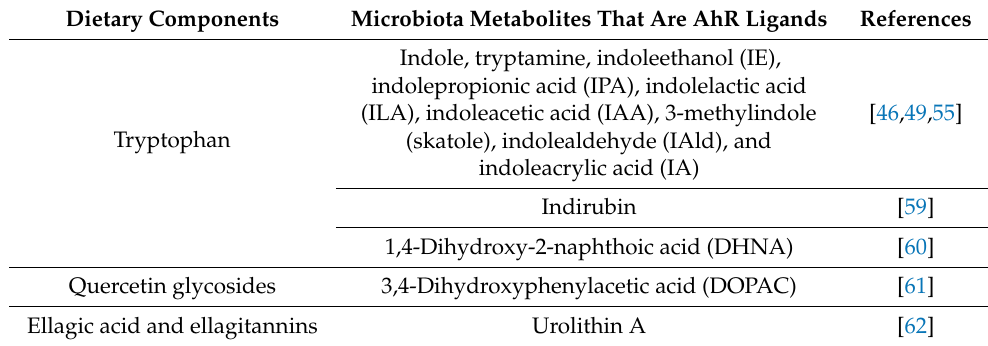
Table 2. Dietary components and microbiota metabolites that are AhR ligands. Dietary